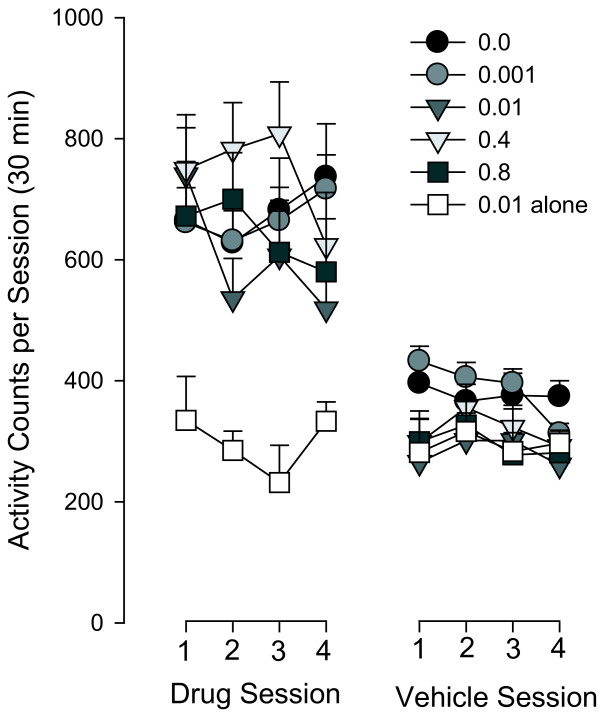
Mean (+SEM) activity counts (per 30 min) during conditioning sessions. Activity counts on the drug- (left panel) and vehicle-paired (right panel) sides are shown. Groups were treated with 0.0 – 0.8 μg EGLU followed by amphetamine (20 μg) immediately before placement on the corresponding side of the conditioning apparatus. One group received 0.1 μg EGLU alone, i.e. no amphetamine was administered before conditioning sessions. See Table 1 for number of animals per group.